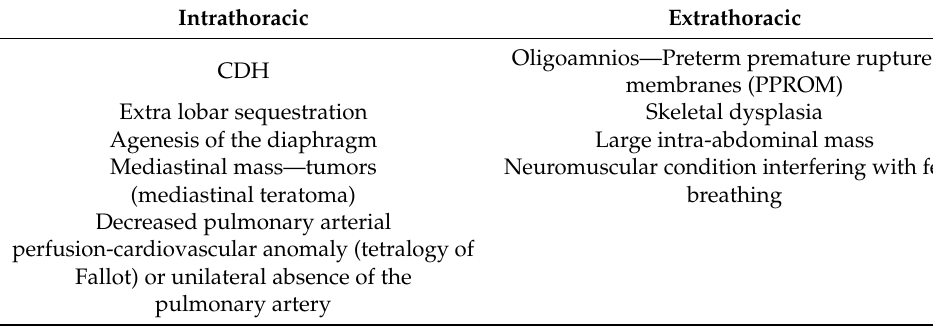
Table 1. Causes of intra and extra thoracic cavity volume